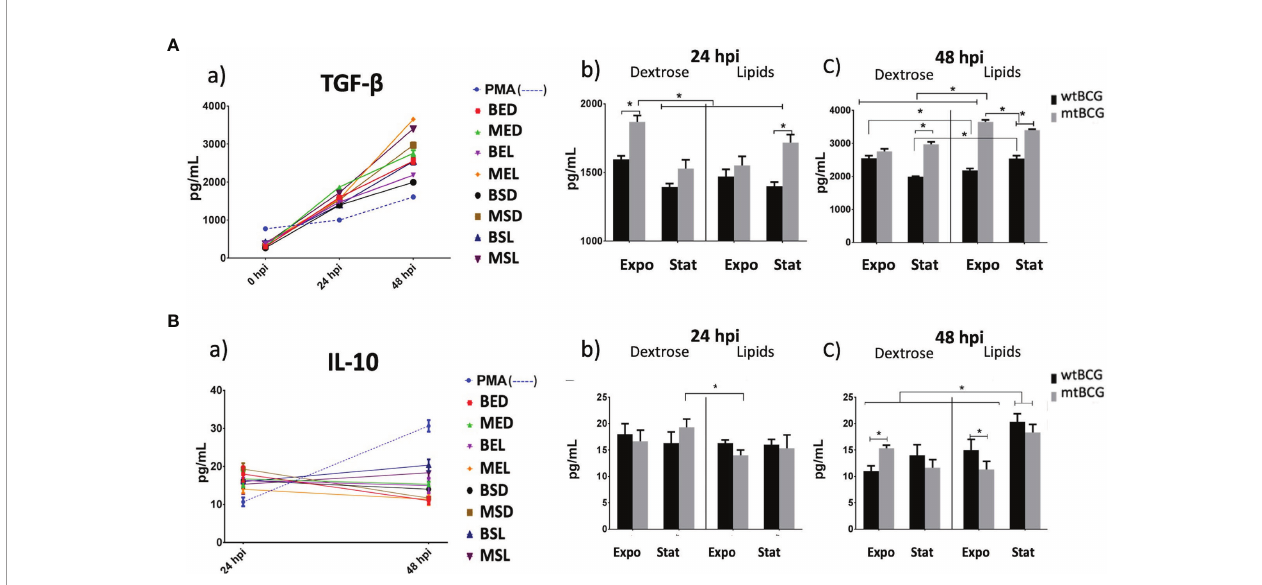
FIGURE 10 | Anti-in fl ammatory cytokine expression on THP-1 macrophages infected with M. bovis BCG strains. Expression of TGF- b and IL-10 ( A, B , respectively) was determined by ELISA in supernatants collected from different infection times. Signi fi cant changes in the concentrations of each cytokine are shown at 24 and 48 hpi (panels b, c ). IL-10 production at 0 hpi was less than the detection limit of the kit. In each determination, a positive control (cells overstimulated with 100 nM PMA) was used (dotted lines). All experiments were performed in triplicate using wtBCG or mtBCG cultured in dextrose or lipids during the exponential phase (BED, wtBCG dextrose; BEL, wtBCG lipids; MED, mtBCG dextrose; MEL, mtBCG lipids) or the stationary phase (BSD, wtBCG dextrose; BSL, wtBCG lipids; MSD, mtBCG dextrose; MSL, mtBCG lipids). *, p <